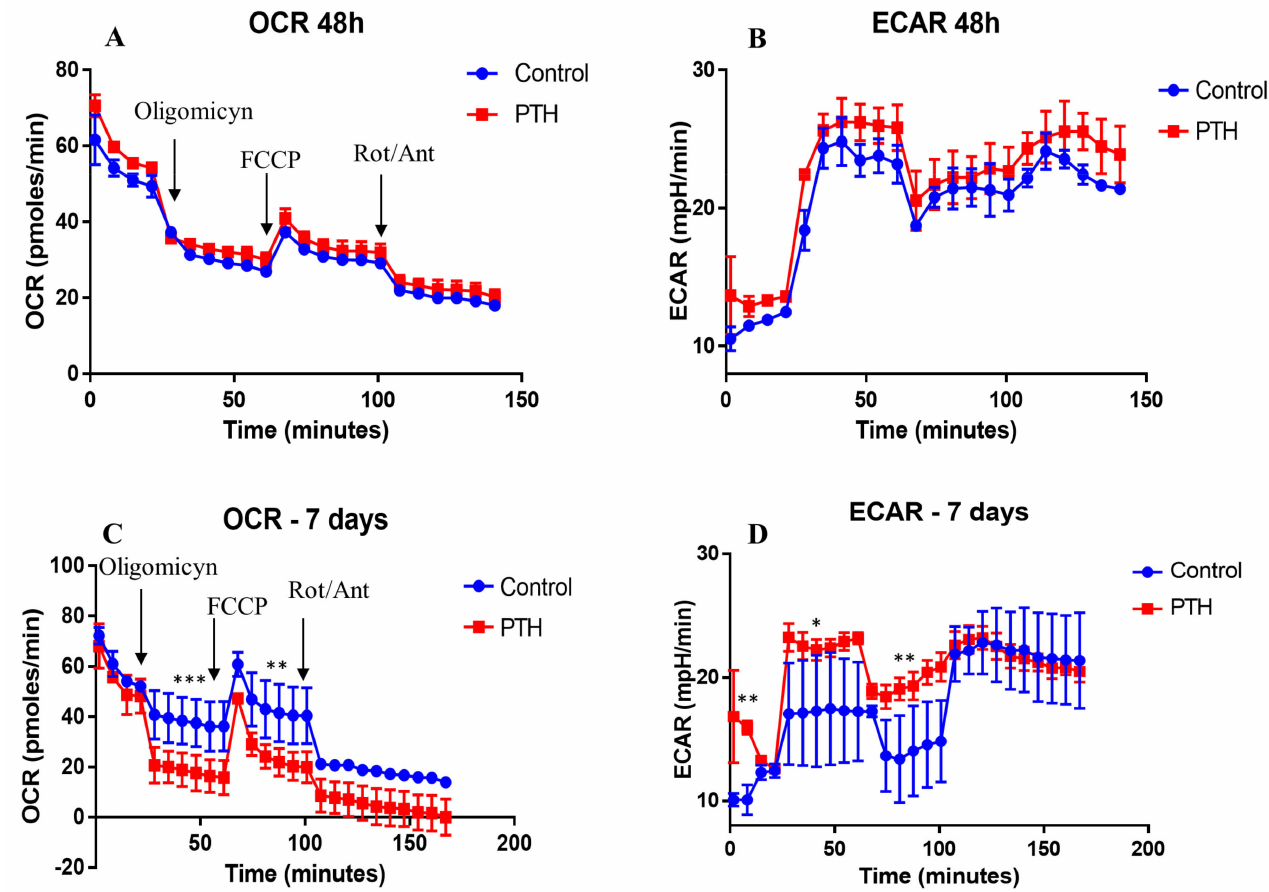
Figure 3. The effect of PTH on mitochondrial respiration and glycolysis in VEC. ( A , C ) Mitochon- drial respiration presented as OCR (a measure of oxygen utilization in cells) at 48 h and 7 days after VEC exposure to PTH. Arrows indicate injection of oligomycin (0.5 µ M), carbonyl cyanide- 4-(trifluoromethoxy) phenylhydrazone (FCCP − 1 µ M) and rotenone/antimycin (1 µ M). Each data point represents an OCR measurement. ( B , D ) ECAR—a measure of lactic acid levels, generated by anaerobic glycolysis, quantified under basal conditions and as a response to the same inhibitors, oligomycin, FCCP and rotenone +antimycin. Data are expressed as means ± SEM, n = 4 independent experiments, * p < 0.05, ** p < 0.01, *** p < 0.001 control vs. PTH-exposed